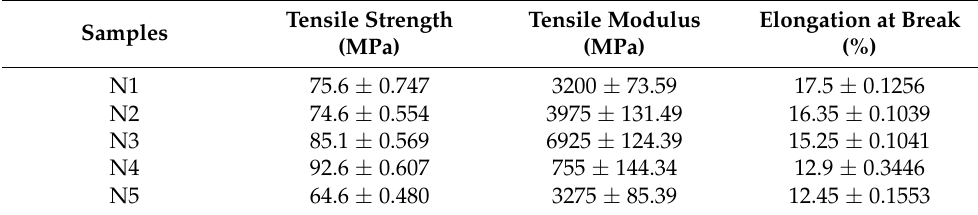
Table 4. Experimental Results for Tensile Strength, Tensile Modulus and Elongation at Break of Composites.